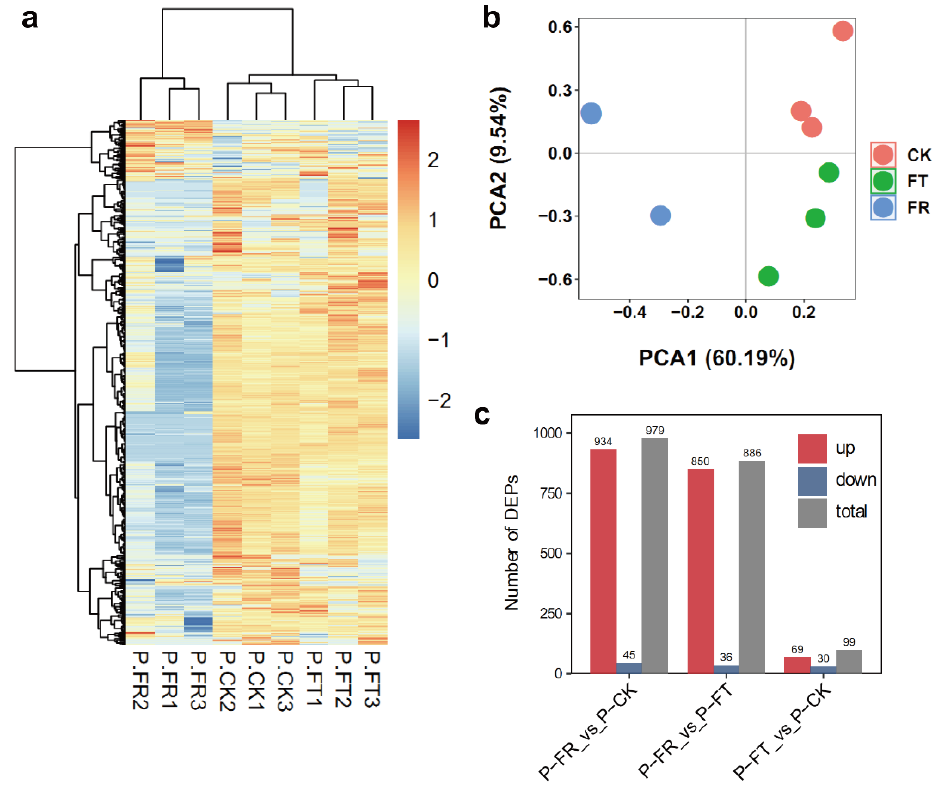
Figure 1. Overview of the proteomes during freezing stress. ( a ) A heatmap of the abundance of proteins in CK, FT, and FR. The bar indicates the significant values. ( b ) PCA analysis of the proteomes in CK, FT, and FR. ( c ) Differentially accumulated proteins (DAPs) in three comparisons.